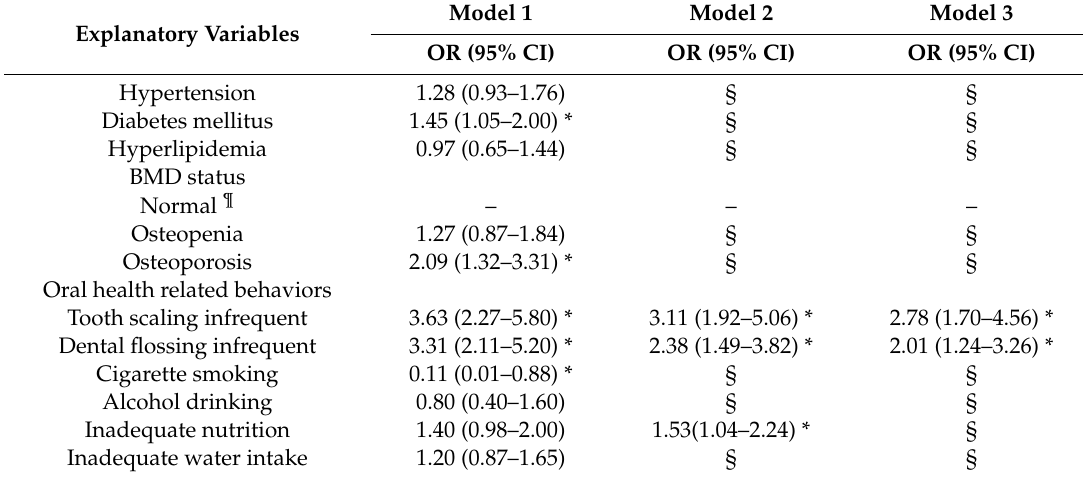
Table 3. Logistic regression analysis of factors associated with NRT <